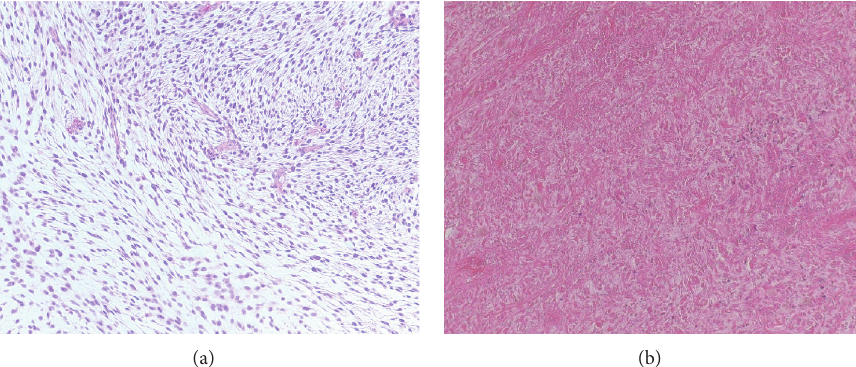
F 3: (a) Densely cellular neoplasm composed of round- and spindle-shaped cells.; (b) necrosis and hyalinization aer neoadjuvant therapy, (H&E staining,